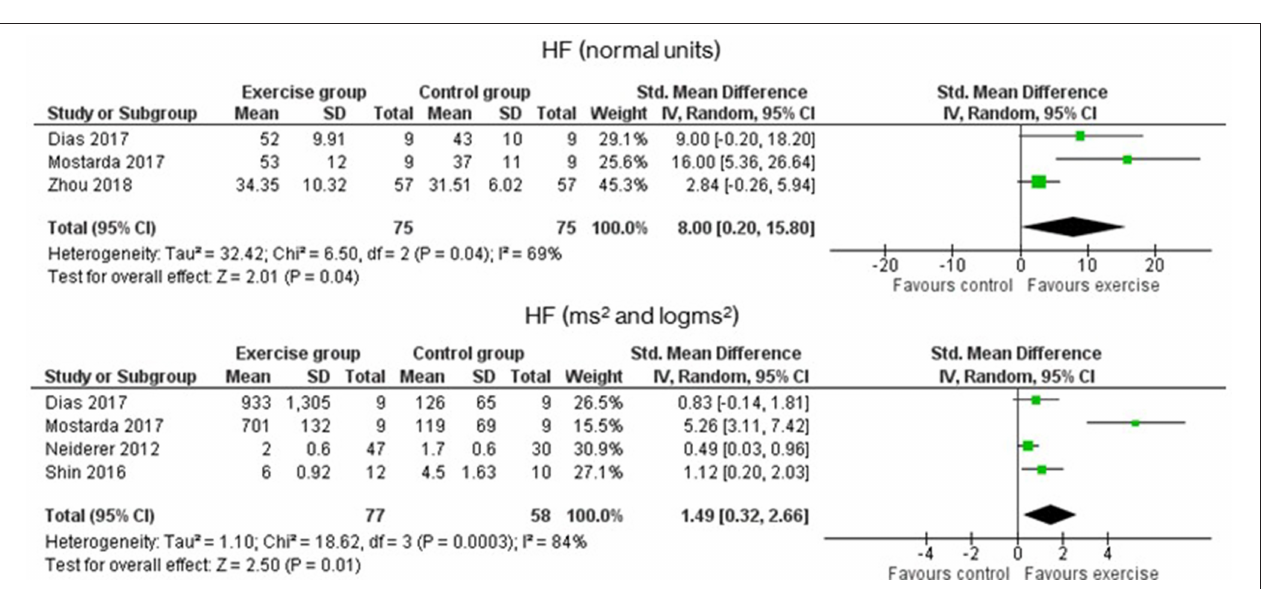
of the programs and the physiological implications of the variables